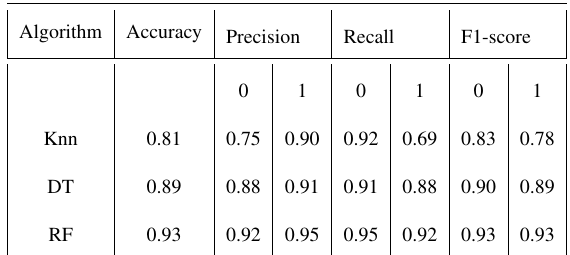
Table 4. Evaluation metrics without tuning Algorithm Accuracy Precision